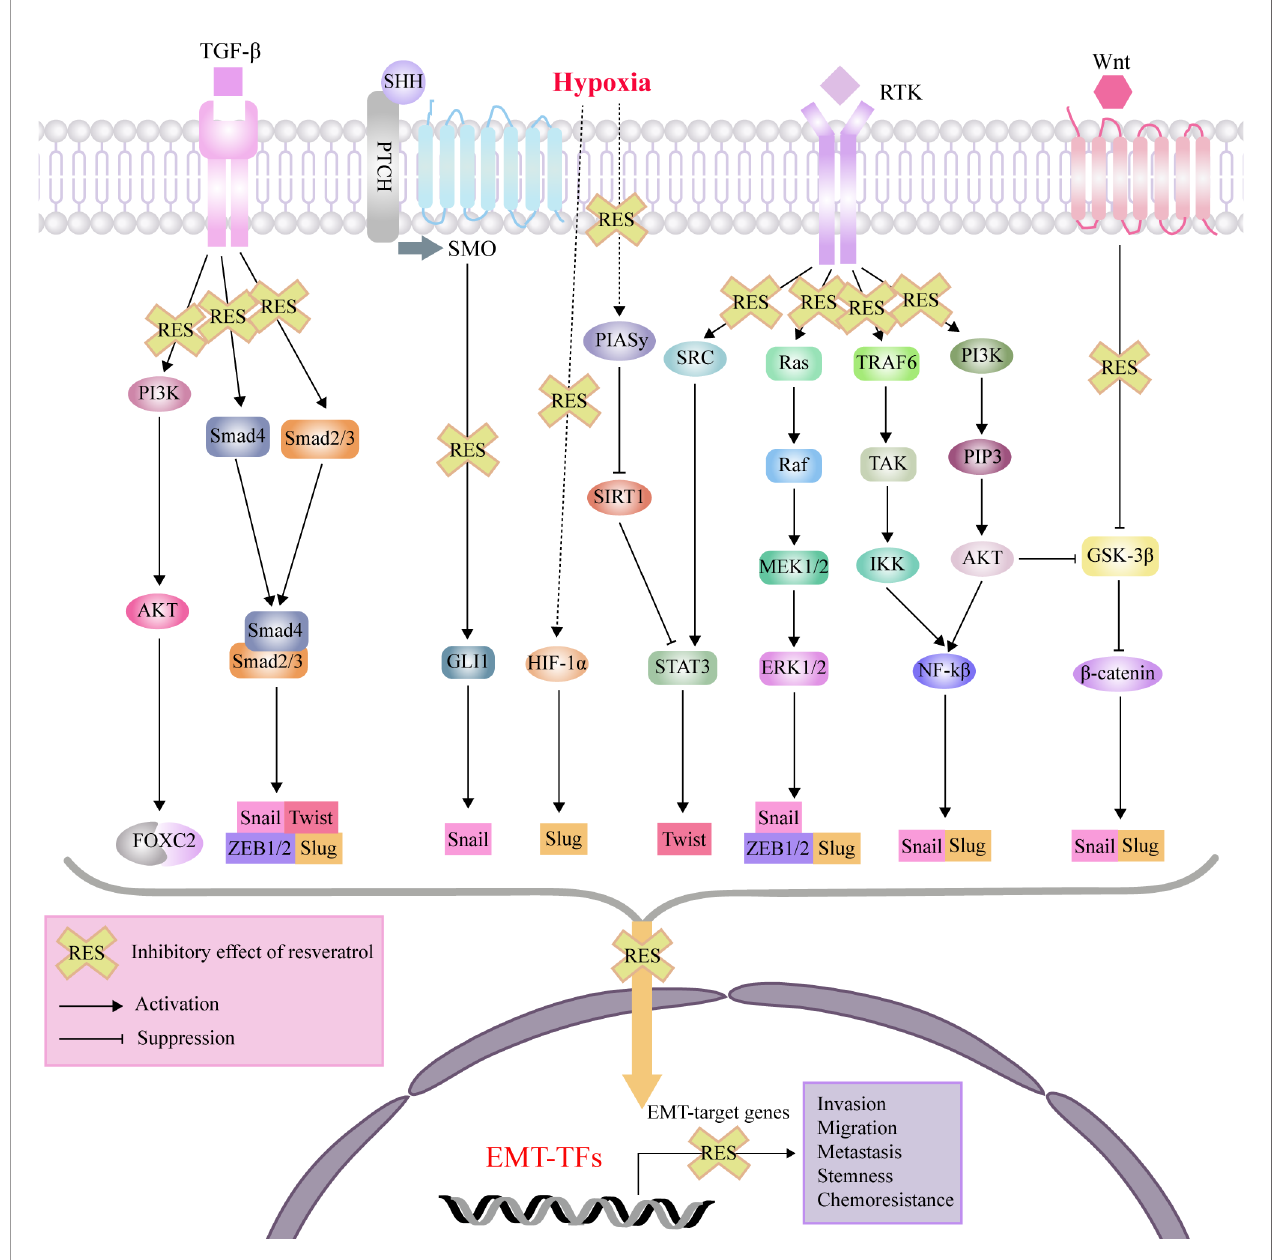
FIGURE 2 | Mechanisms of effects of RES through interference with signaling pathways affecting EMT, invasion, migration, metastasis, tumor stemness and chemoresistance. protein kinase B (AKT); epithelial-mesenchymal transition (EMT); extracellular signal-regulated kinase (ERK); forkhead box C2 (FOXC2); glioma- associated oncogene 1 (GLI1); glycogen synthase kinase 3 b (GSK-3 b ); hypoxia-inducible factor-1 (HIF-1); inhibitor of nuclear factor kappa-B kinase (IKK); nuclear factor- k B (NF- k B); MAP kinse-ERK kinase (MEK); protein inhibitor of activated STAT 4 (PIASy); patched (PTCH); phosphatidylinositol 3-kinase (PI3K); plasma membrane intrinsic protein 3 (PIP3); receptor tyrosine kinases (RTK); sonic hedgehog (SHH); sirtuin1(SIRT1); smoothened (SMO); signal transducer and activator of transcription 3 (STAT3); transforming growth factor- b (TGF- b ); TGF beta-Activated Kinase (TAK); TNF-receptor associated factor 6 (TRAF6); zinc fi nger E-box binding homeobox